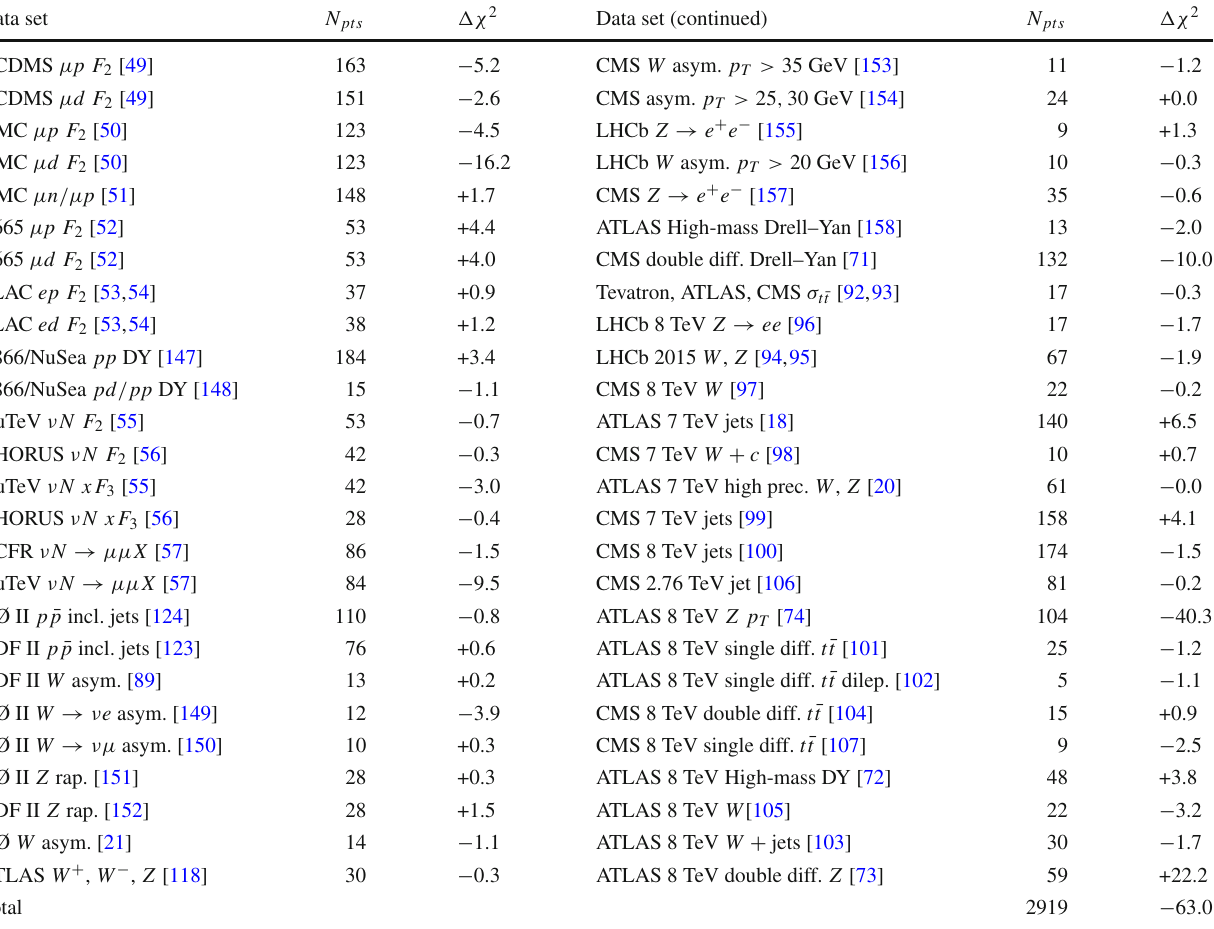
Table 15 The change in χ 2 (with negative indicating an improvement in the fit quality) when the combined HERA data sets including F L and heavy flavour data are removed, illustrating the tensions of these data sets with several of the other data sets in the global